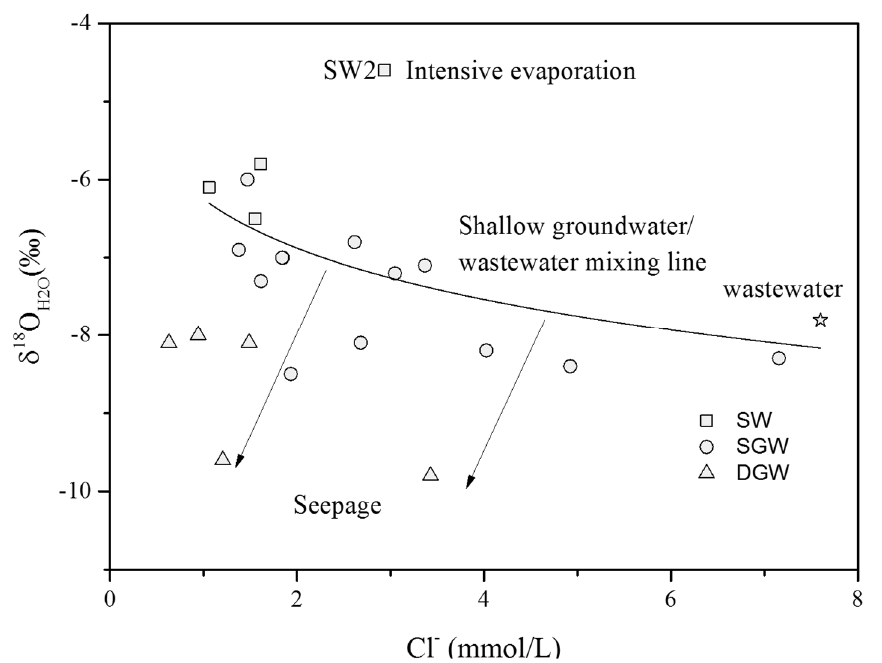
Figure 7. Cl − concentrations vs. δ 18 O H2O values in the surface water and